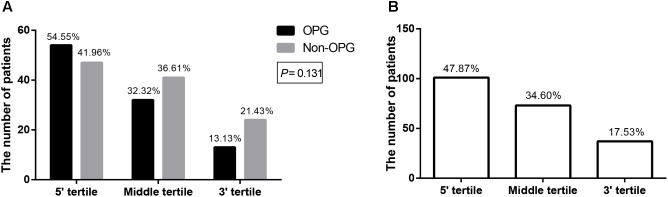
Bar graph depicting the number of patients with mutations located in different tertiles of NF1. The number of patients with mutations located in different tertiles of NF1 in the OPG group versus Non-OPG group (A) and total patients (B). The number above each bar represents the percentage in the relevant group.